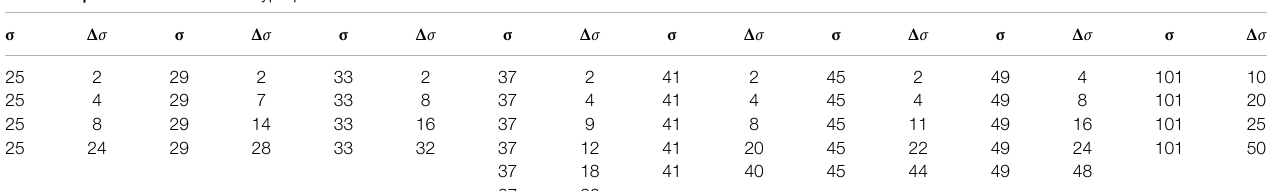
TABLE 2 | The examined set of hyperparameters σ and Δ σ for the local states.